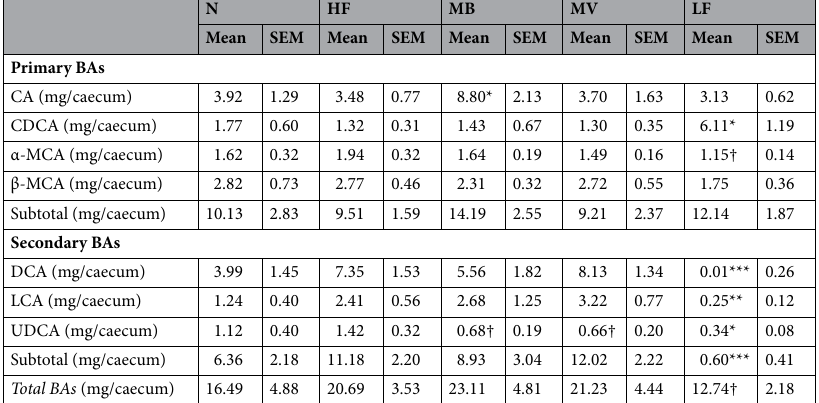
Genus level. Of 75 identified genera, 30 were important for the group separation (Supplementary Figure S1a). The five most important bacteria according to the VIP test (in descending order) were Turicibacter , Holdemania , an unidentified genus in the Christensenellaceae family, Mucispirillum and Eubacterium. The HF group (Supplementary Figure S1b) had higher abundance of an unidentified genus in the S24‑7 family